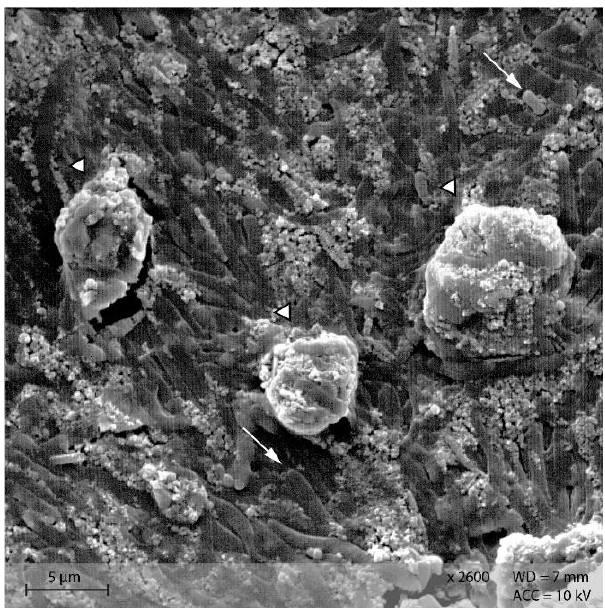
Figure 14. Starch granules in the course of degradation, surrounded by bacteria and small frag- ments. Sample of caecum content from group PEL (Scanning electron microscopy, ↓ indicating bac- teria, ∆ marking the starch granules).